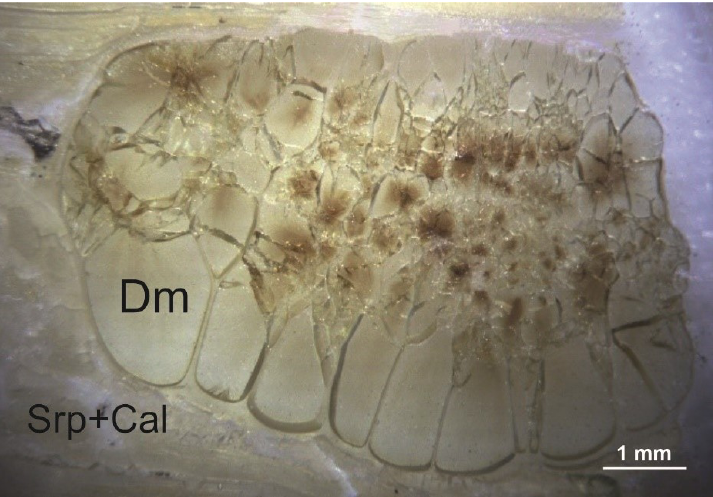
Figure 3. Slice of a rounded aggregate of demantoid in the carbonate-serpentine vein (Poldnevskoye deposit). Srp+Cal: serpentine and calcite, Dm: andradite (brown - Ti-containing, light yellow-green-demantoid). Photo by E.S. Karaseva .